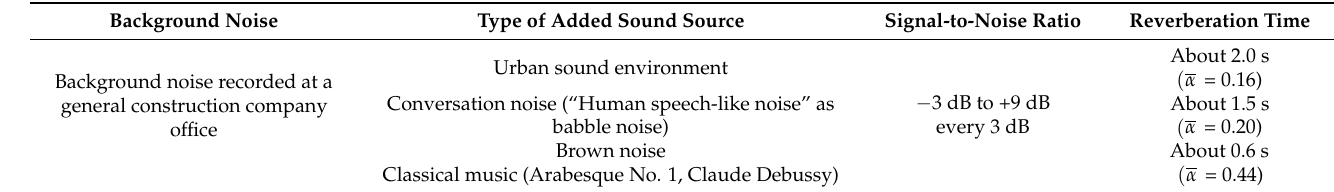
Table 1. The sound environment conditions used in the present study.